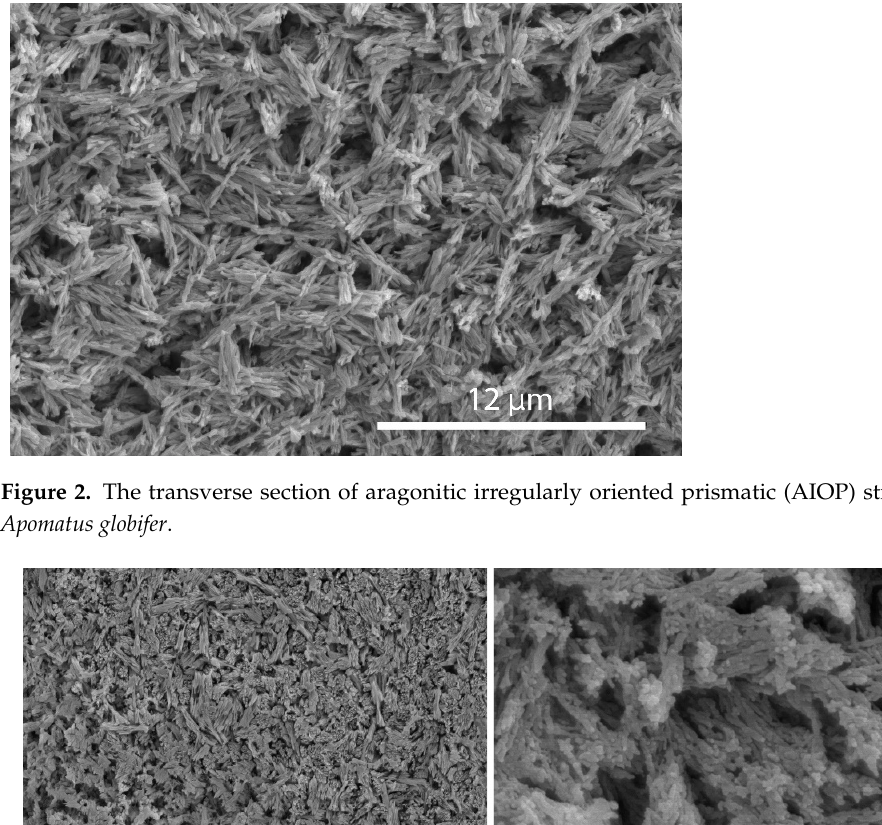
Figure 2. The transverse section of aragonitic irregularly oriented prismatic (AIOP) structure in Apomatus globifer .